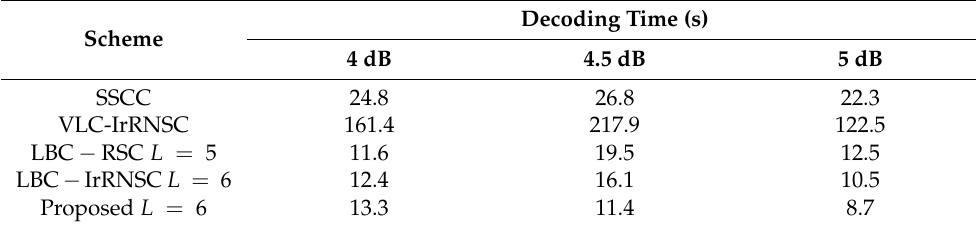
Table 6. Simulation decoding time of different source channel coding schemes.